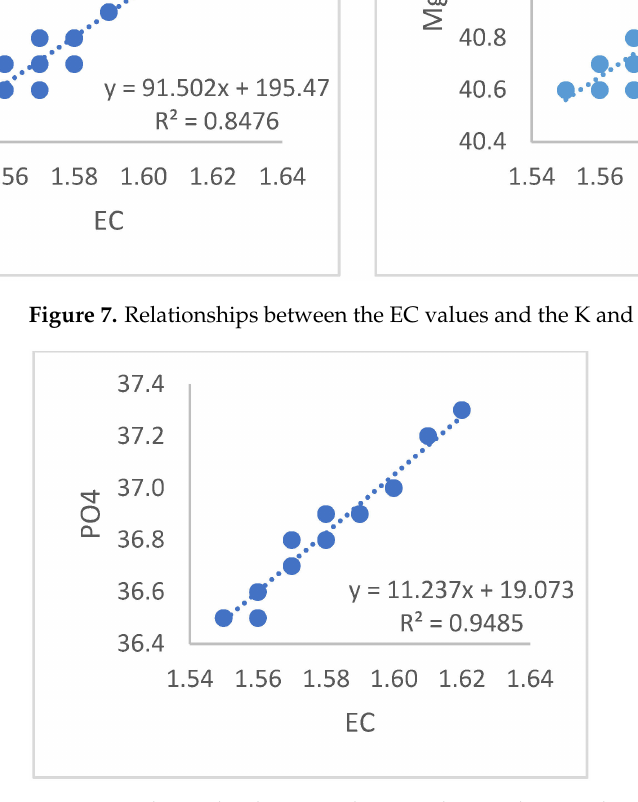
Figure 8. Relationship between the EC values and PO 4 values of the liquid in the